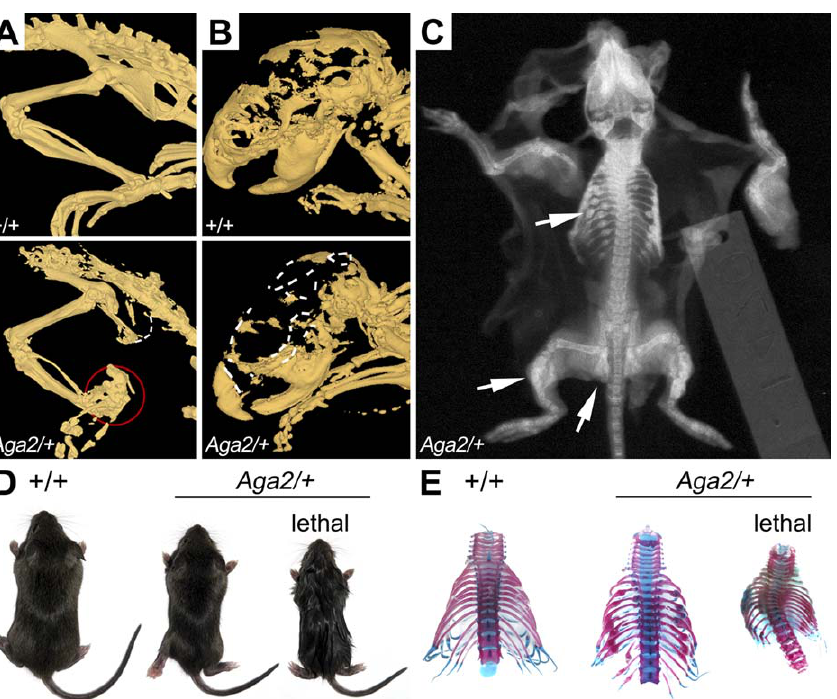
Figure 2. Aga2 / þ Skeletal and Growth Abnormalities (A) Lateral l CT views of 12-wk-old male skeletons highlight the axial vertebrae, pelvis (white trace), and hind limb (encircled) defects in Aga2 / þ mice. (B) Cranial features of a 16-d-old lethal Aga2 / þ mouse. (C) Skeletal radiograph of a 16-d-old lethal Aga2 / þ animal. Provisional-bony rib and long bone calluses and deteriorated pelvis depicted with arrows. (D) Severe growth defects in Aga2 / þ animals. (E) Skeletal preparations.